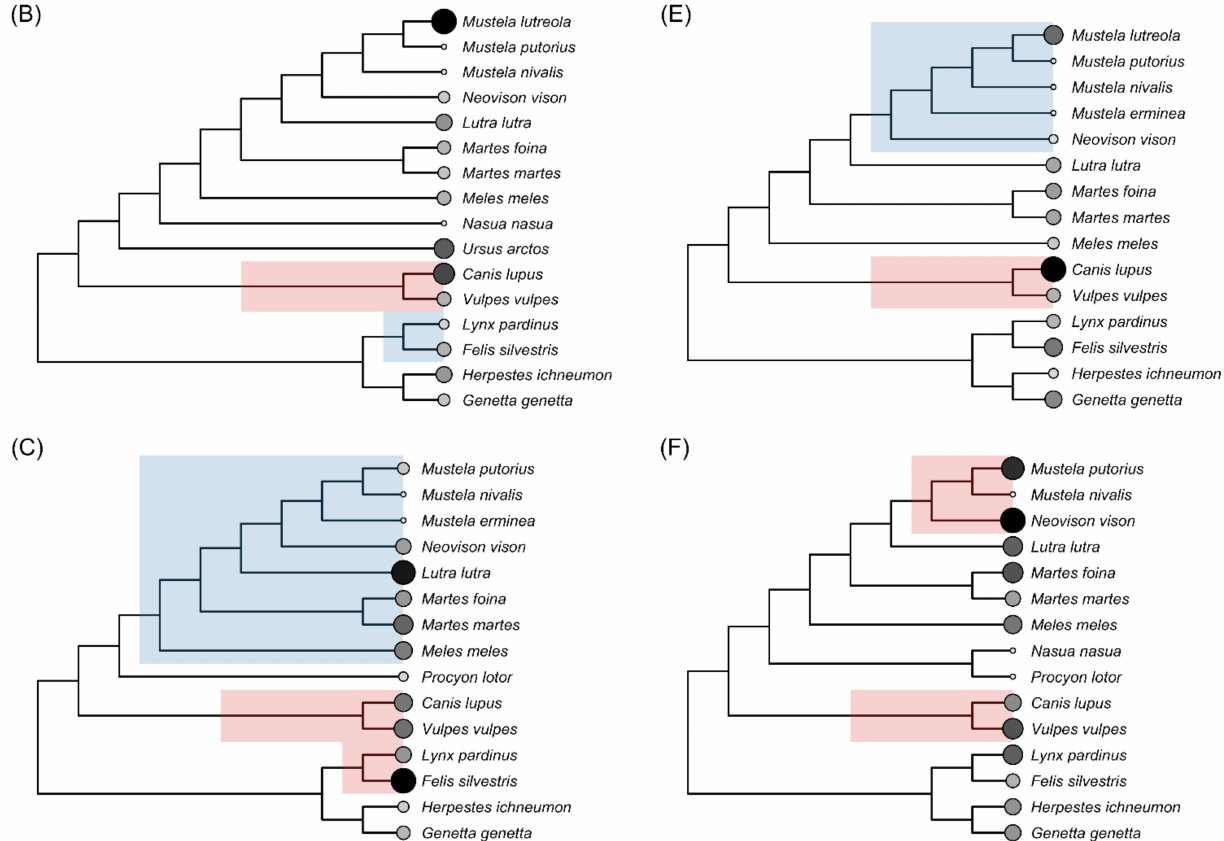
Figure 6. Taxonomic patterns in infection prevalence ( A – C ) and seroprevalence ( D – F ) for bacteria (top), viruses (middle), and protozoa (bottom) across the Iberian carnivore phylogeny. Points are scaled and colored by the total proportion of positive hosts. Shading denotes clades with greater (red) or lesser (blue) of each response compared to the paraphyletic remainder as identified by phylogenetic factorization.